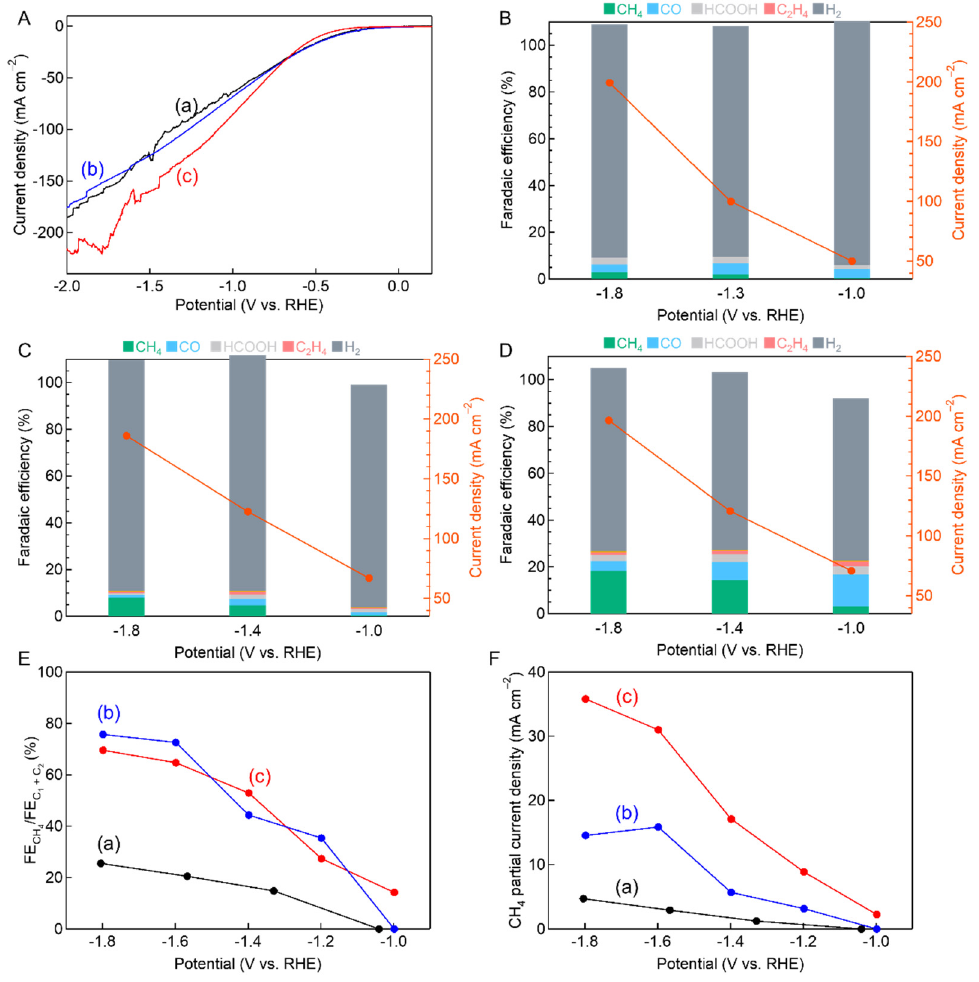
Figure 6. LSV curves under CO 2 flow ( A ) on an electrode employing (a) TiO 2 , (b) Cu-TiO 2 , and (c) Cu-TiO 2 -H catalyst. FEs for different products over TiO 2 ( B ), Cu-TiO 2 ( C ), and Cu-TiO 2 -H ( D ) catalysts at various potentials. Comparison of FE CH4 /FE C1 + C2 ( E ) on (a) TiO 2 , (b) Cu-TiO 2 , and (c) Cu-TiO 2 -H catalyst. Comparison of CH 4 partial current density ( F ) of (a) TiO 2 , (b) Cu-TiO 2 , and (c) Cu-TiO 2 -H catalyst.